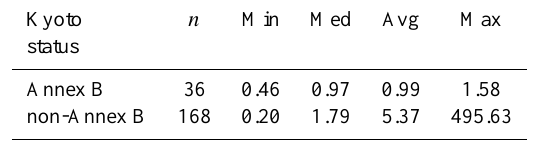
Table 2b. Basic statistics regarding trends in normalized national FFCO2 emissions for Annex B and non-Annex B countries from years 1990 to 2007. n = number of countries, min = minimum an- nual growth factor for the n countries (equal country weighted, not weighted by mass per country), med = median annual growth fac- tor, avg = average annual growth factor, max = maximum annual growth factor. The growth factor is defined as the year 2007 FFCO2 emissions divided by the year 1990 FFCO2 emissions. For some countries proportional emissions were used in 1990 or 2007 as the countries were disaggregated (e.g. former Soviet Union) or aggre- gated (e.g., Yemen). Thirteen non-Annex B countries (all relatively small FFCO2 emitters, the largest equal to less than 0.2% of the sum of countries total FFCO2 emissions) were excluded from the analysis because the 1990 data year FFCO2 emissions data were incomplete or missing. Data from Boden et al. (2010).